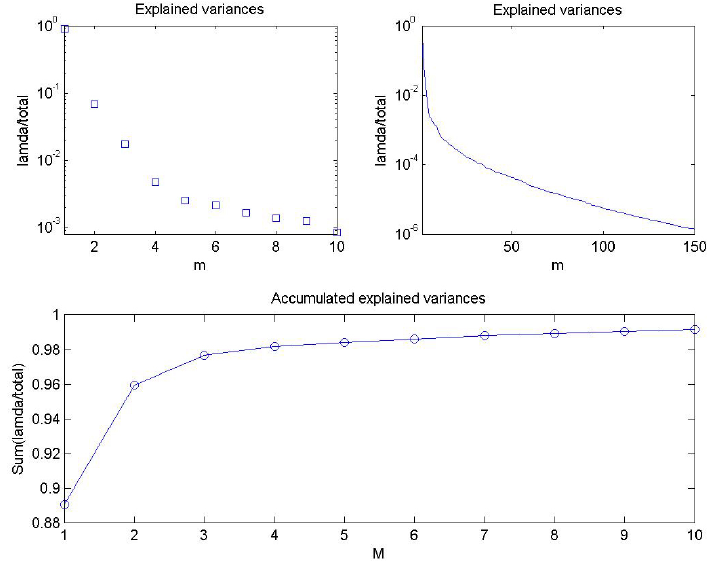
Figure 1. Explained variance r 2 m vs. m and the accumulated explained variance R 2 time period (4180 days) from 1999 to 2010 and 72 × 71 spatial grids.